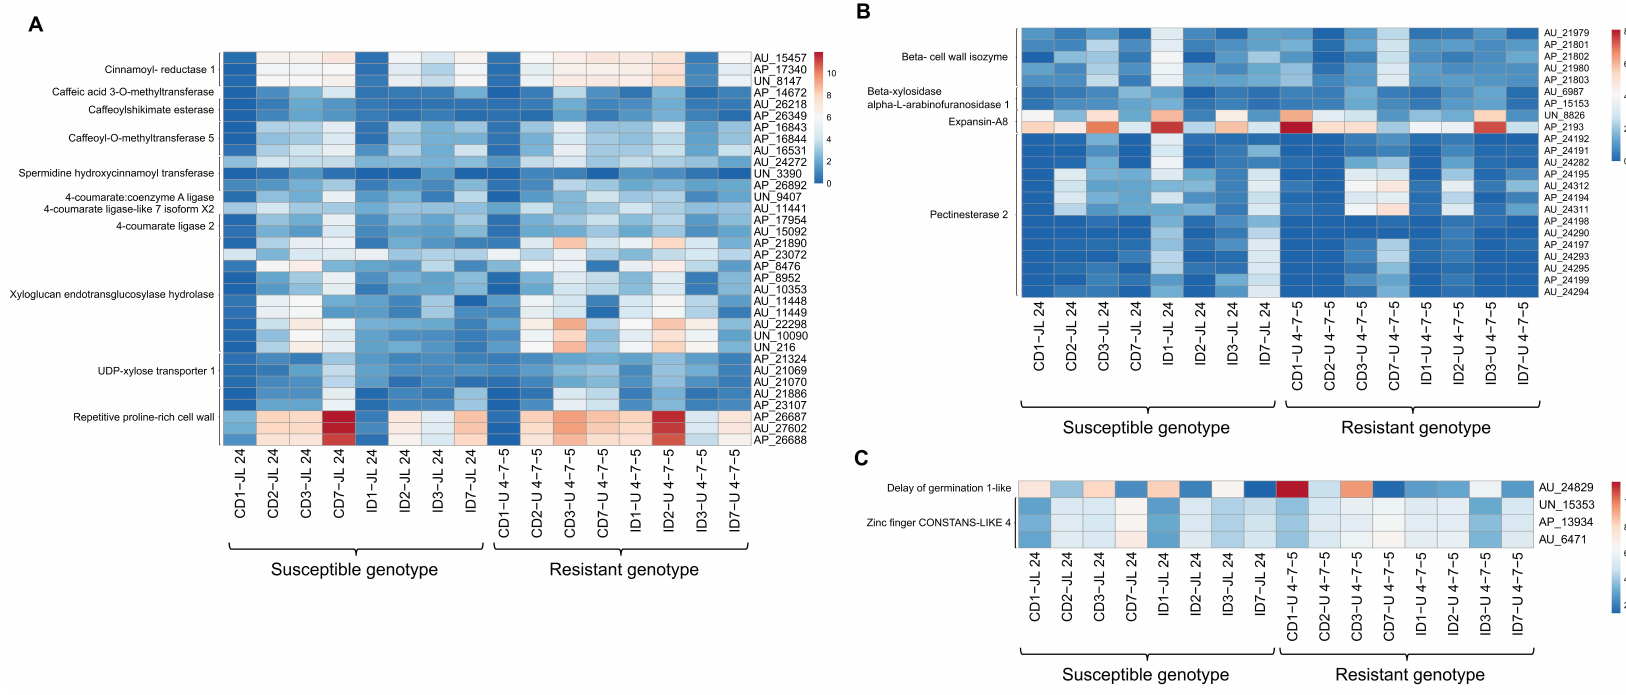
Figure 7. Di ff erentially expressed genes related to cell wall and seed germination. Heat maps of ( A ) genes related to cell wall metabolism pathways in 16 groundnut genotypes during control and infected conditions in response to A. flavus . The red color depicts the upregulation and blue color depicts the downregulation in the gene expression pattern. The color code corresponds to the FPKM value of the transcripts which increase from yellow to purple color. Genotype and treatment level are shown at the top of the figure. Heat maps of ( B ) cell wall catabolizing gene transcripts a ff ected in 16 groundnut genotypes during control and infected conditions in response to infection with A. flavus . Heat maps of ( C ) seed germination related genes transcripts a ff ected in 16 groundnut genotypes during control and infected conditions in response to A.